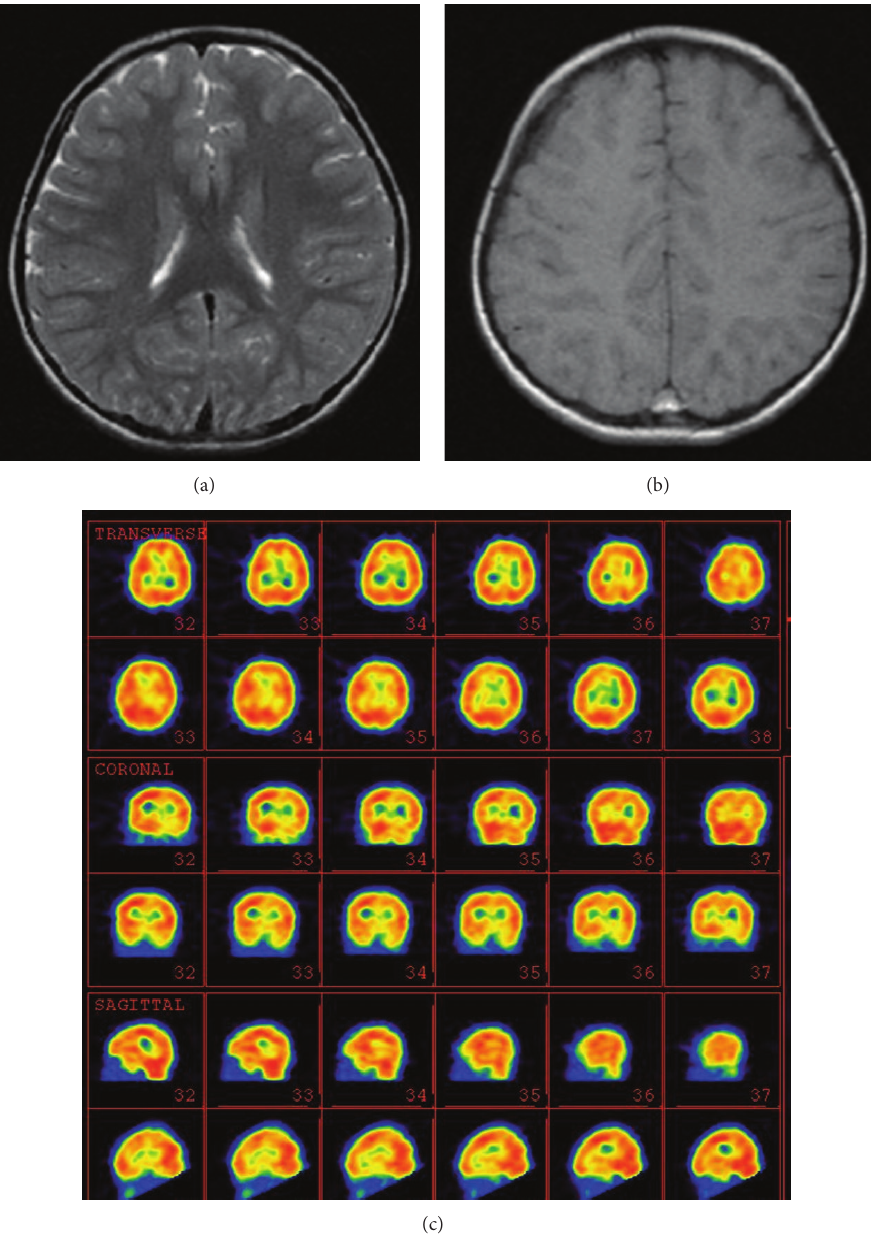
Figure 1: ((a), (b)) The MRI images of a 6-year-old boy with Landau-Kleffner syndrome (LKS). (c) 99mTc-ECD brain perfusion SPECT image showed hypoperfusion in the left inferior frontal, left temporal, and also left thalamic regions. The upper rows indicate transverse 99mTc-ECD SPECT images. The middle rows indicate coronal 99mTc-ECD SPECT images. The lower rows indicate sagittal 99mTc-ECD SPECT